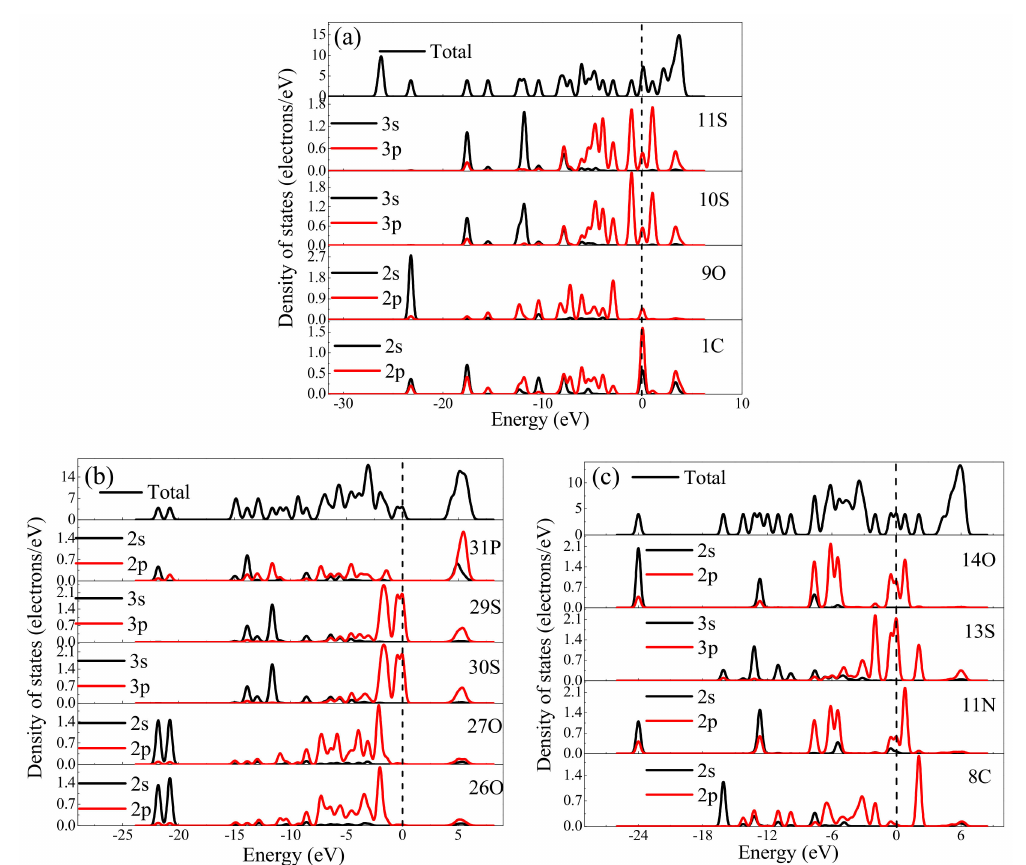
Figure 7. Densities of states of collectors (( a ) IPETC; ( b ) ADDTP; ( c )